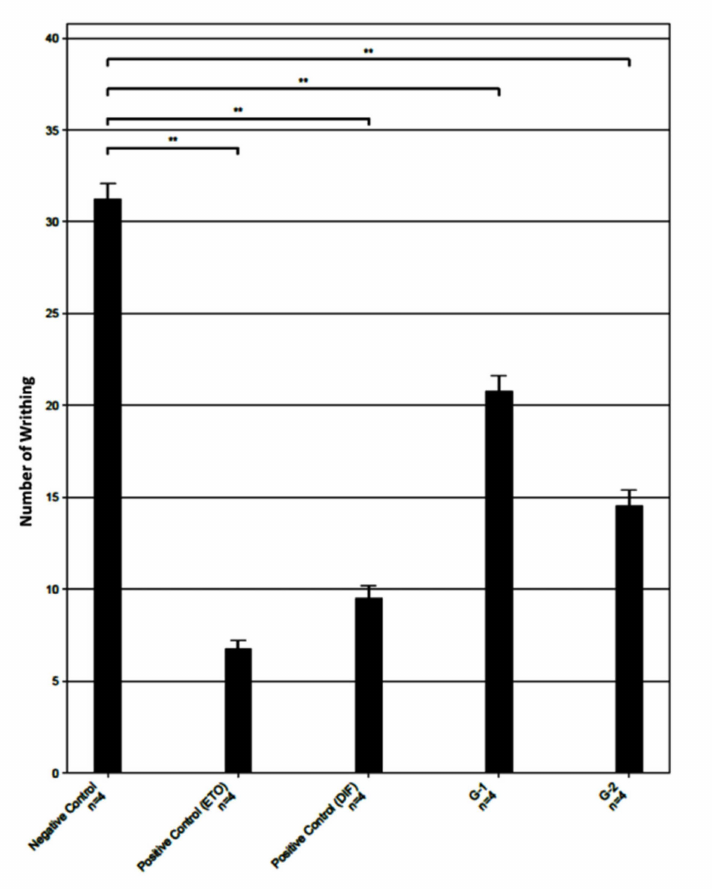
Figure 2. Acetic acid induced writhing response in mice model after treatment with ethanolic extract of MH leaves. G-1 is 200 mg/kg and G-2 is 400 mg/kg of MH leaves extract. Number of mice in each group, n = 4; values are expressed as mean ± S. D.; ** p < 0.001 when compared to negative